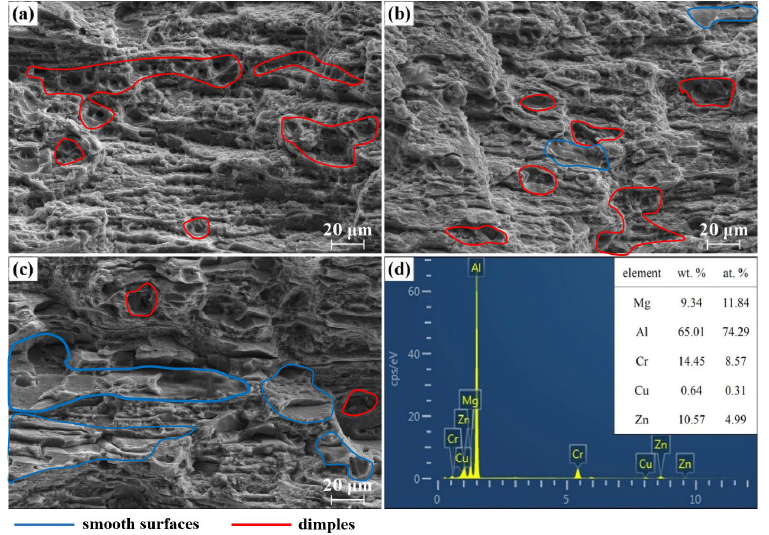
Figure 3. Fracture morphology of Al-5Zn-2.6Mg-xCu alloys at room temperature: ( a ) x = 0.24 wt.%; ( b ) x = 0.43 wt.%; ( c ) x = 0.91 wt.%; and ( d ) chemical composition of the second phase of dimples.